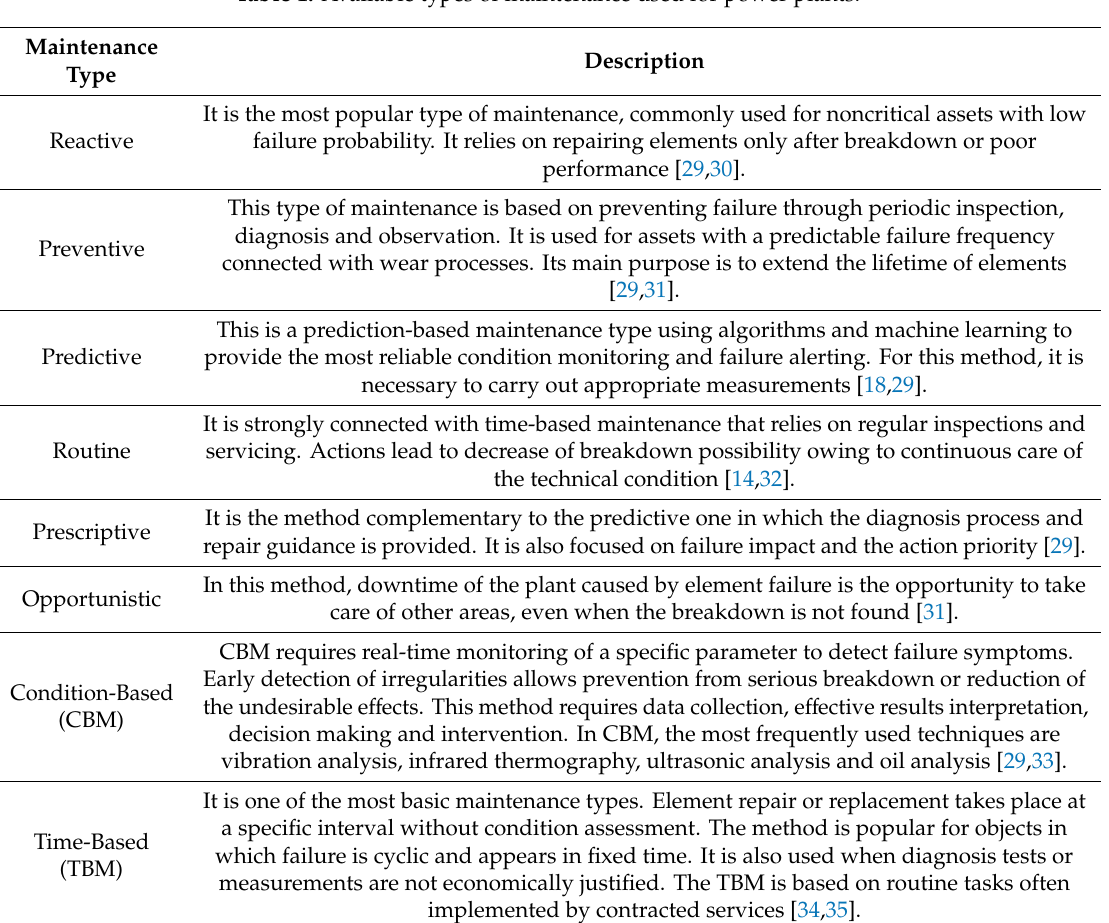
Table 1. Available types of maintenance used for power